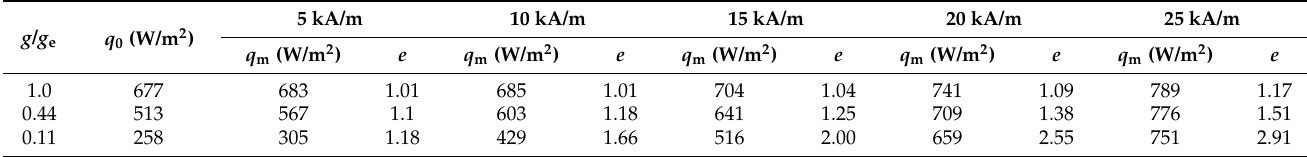
Table 3. Averaged heat flux and heat flux enhancement ratio under a non-uniform magnetic